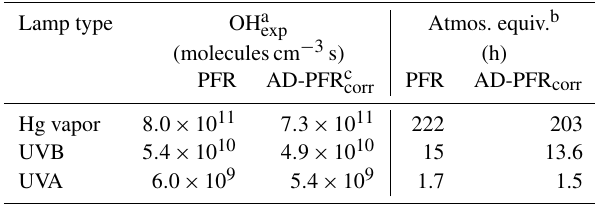
Table 1. Simulated OH exposure under full light